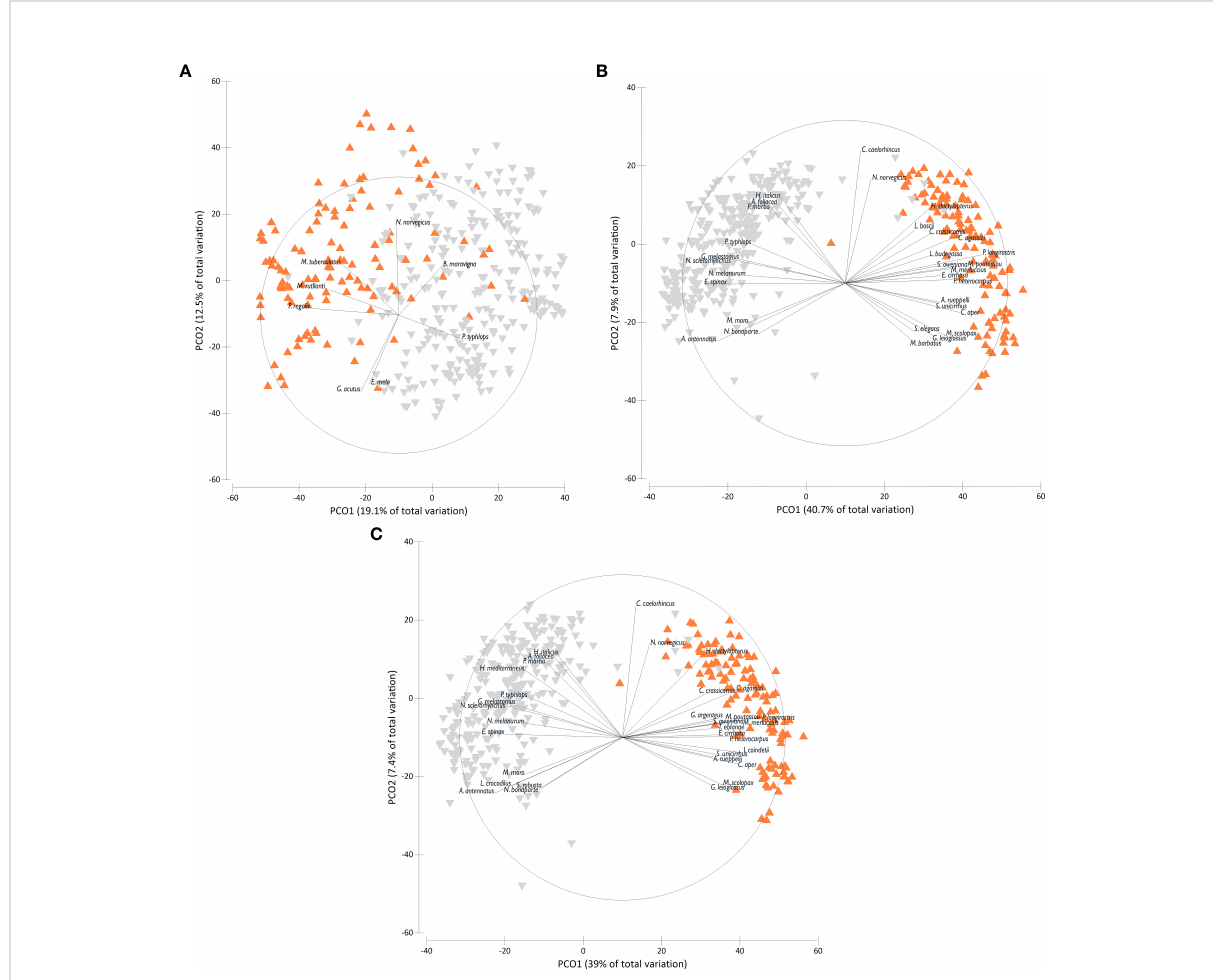
FIGURE 3 Principal Coordinate (PCO) analysis ordination plot based on Bray – Curtis similarity applied to the species-stations matrix of the deep-sea assemblage structure classi fi ed according to the two depth groups (orange = 200-400 m and grey = 400-800 m) in the north-western Ionian Sea for: (A) Benthic species only, (B) Benthic and demersal species, (C) Benthic, demersal and benthopelagic